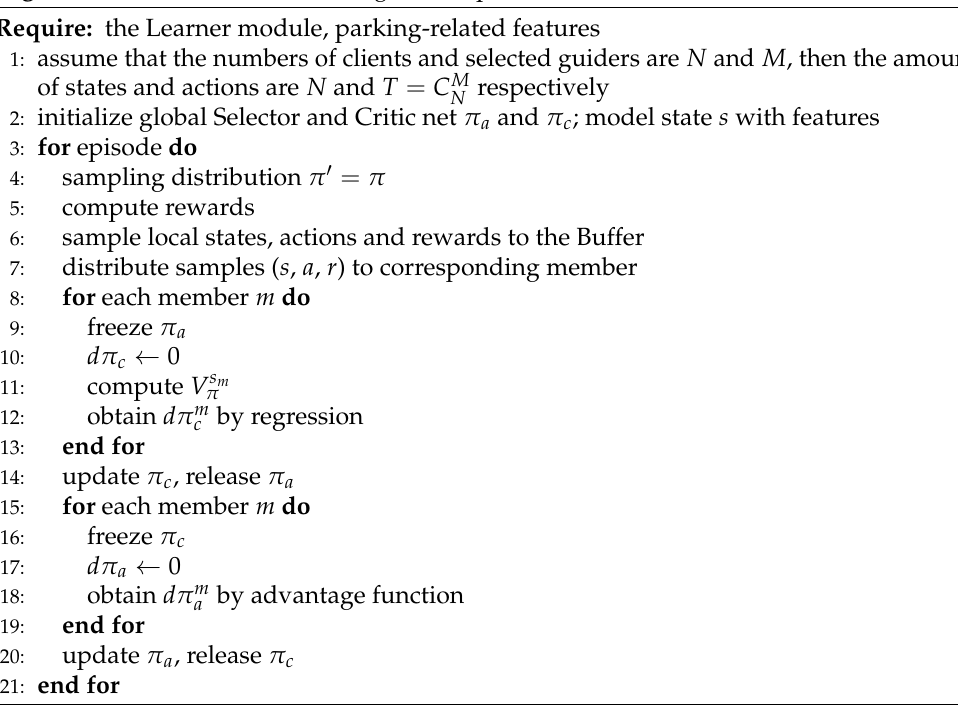
Algorithm 2 Auto-Selector Training: